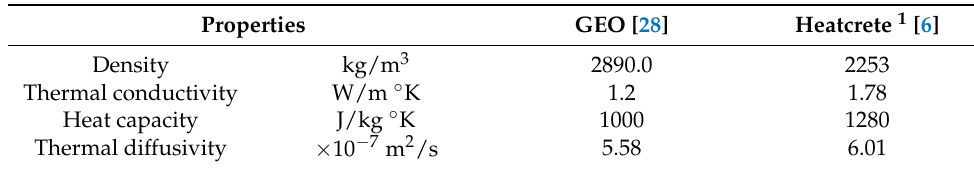
Table 3. Thermal properties of